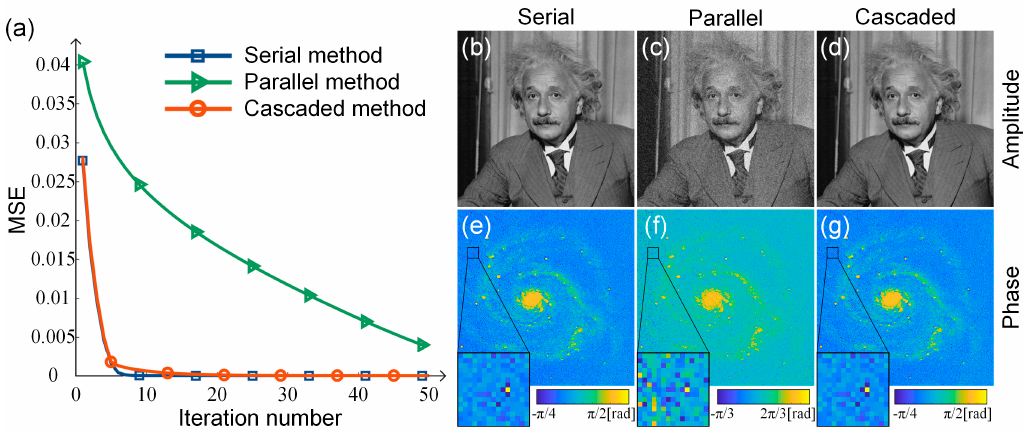
Figure 5. The convergence speed curves and the reconstructed objects. ( a ) The relationship between iteration number and mean square error (MSE) of the reconstructed amplitude from serial, parallel, and the proposed cascaded reconstruction algorithms, n 1 = 5, N = 50. ( b – d ) Reconstructed amplitudes of the three methods after 50 iterations; ( e – g ) corresponding phases.